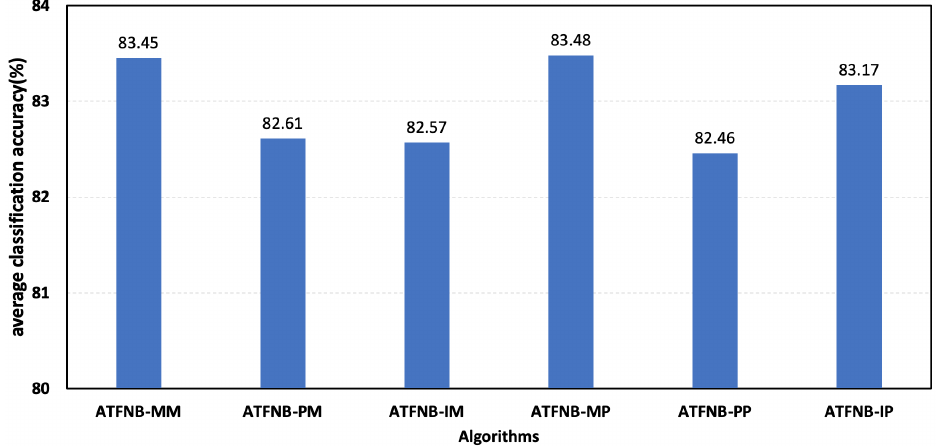
Figure 4. Average accuracy of six combinations.